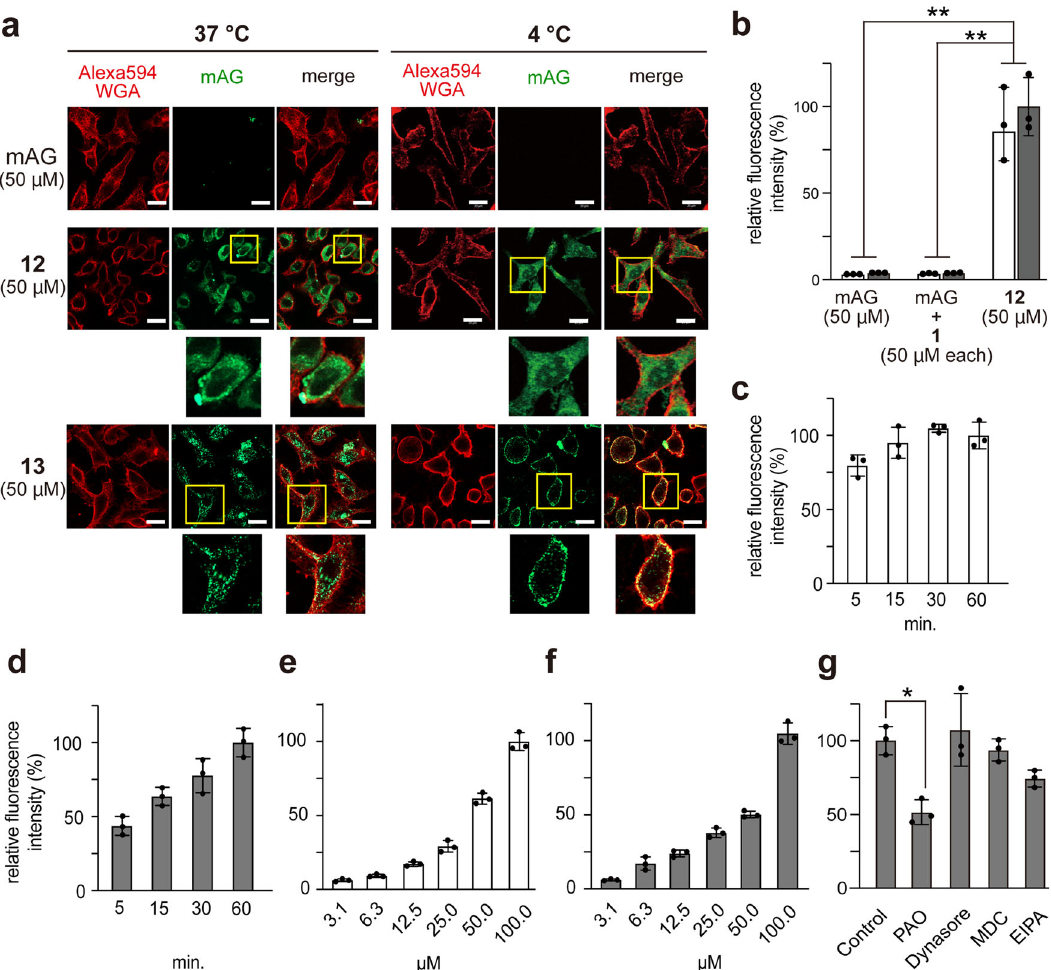
Fig. 4 Cytosolic deliveries of mAG conjugated with ε -P α L. a Cytosolic delivery of mAG conjugated with ε -P α L ( 1 ) or R8. HeLa cells were incubated with mAG, ε -P α L-mAG ( 12 ), and R8-mAG ( 13 ) for 60 min at 37°C and 4°C. After washing and fi xing the cells, the cellular localization of 12 (green) and 13 (green) was determined by CM. The cell membrane was stained with Alexa594-WGA (red). The representative CM images and the magni fi ed views of the yellow-boxed areas are shown. Scale bars, 20 µ m. b – g Relative cellular uptakes of 12 at 37°C (light gray) and 4°C (white). mAG, mAG blended with 1 (mAG + 1 ) and 12 were incubated with HeLa cells for 60 min at 37°C and 4°C. The results are presented as the mean±s.d. ( n = 3). **Signi fi cant at p <0.01 by two-way ANOVA followed by Sidak ’ s multiple comparisons test ( b ). Protein 12 (50 µ M) was incubated with cells for 5 – 60 min at 4°C ( c ) and 37°C ( d ). Protein 12 (3.1 – 100 µ M) was incubated with cells for 60min at 4°C ( e ) and 37°C ( f ). Effect of endocytosis/macropinocytosis inhibitors on the cellular uptake of 12 . HeLa cells were incubated with 12 for 60min at 37°C in the culture medium supplemented with the inhibitor (PAO, Dynasore, MDC, or EIPA). The results are presented as the mean ±s.d. ( n = 3). *Signi fi cant at p <0.05 by one-way ANOVA followed by Tukey ’ s multiple comparisons test ( g